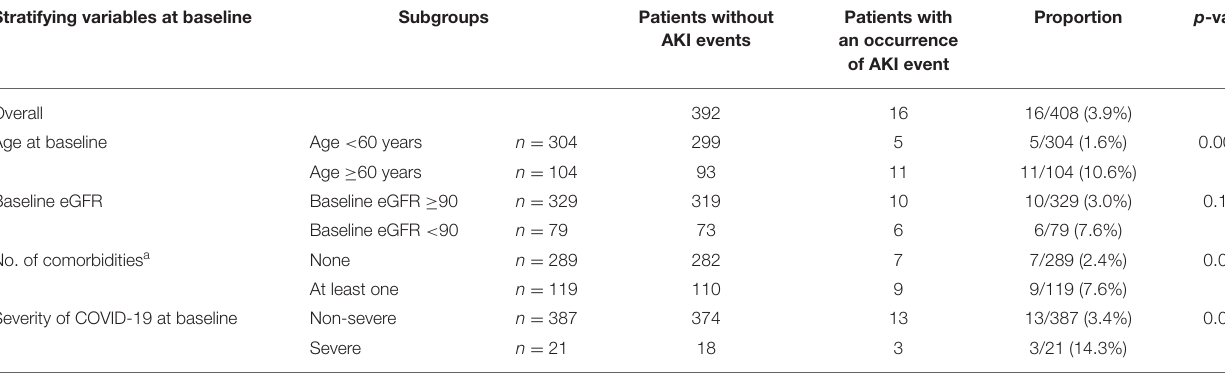
TABLE 2 | Total proportions of AKI occurrence during follow-up stratified by baseline characteristics. Stratifying variables at baseline Subgroups Patients without